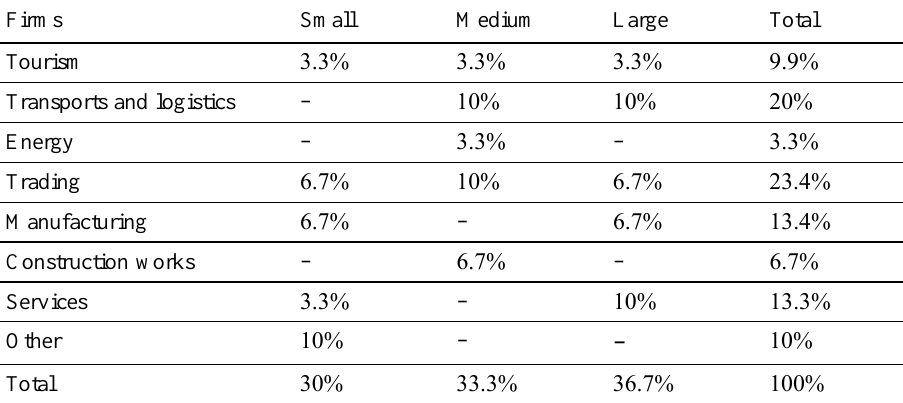
Table 6. Firms’ industry and